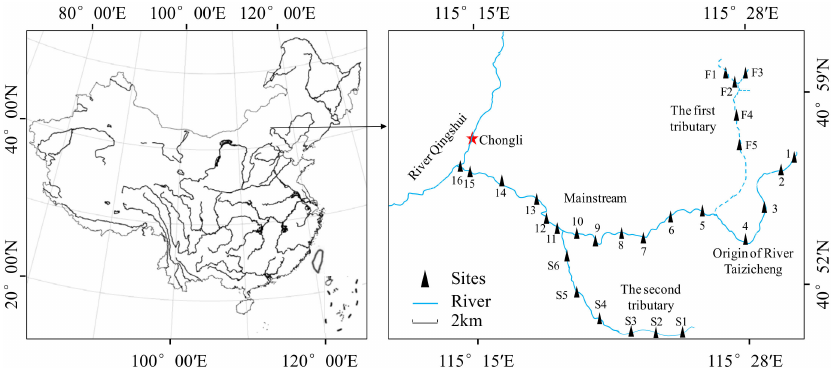
Figure 1. Location of Taizicheng river and the sampling